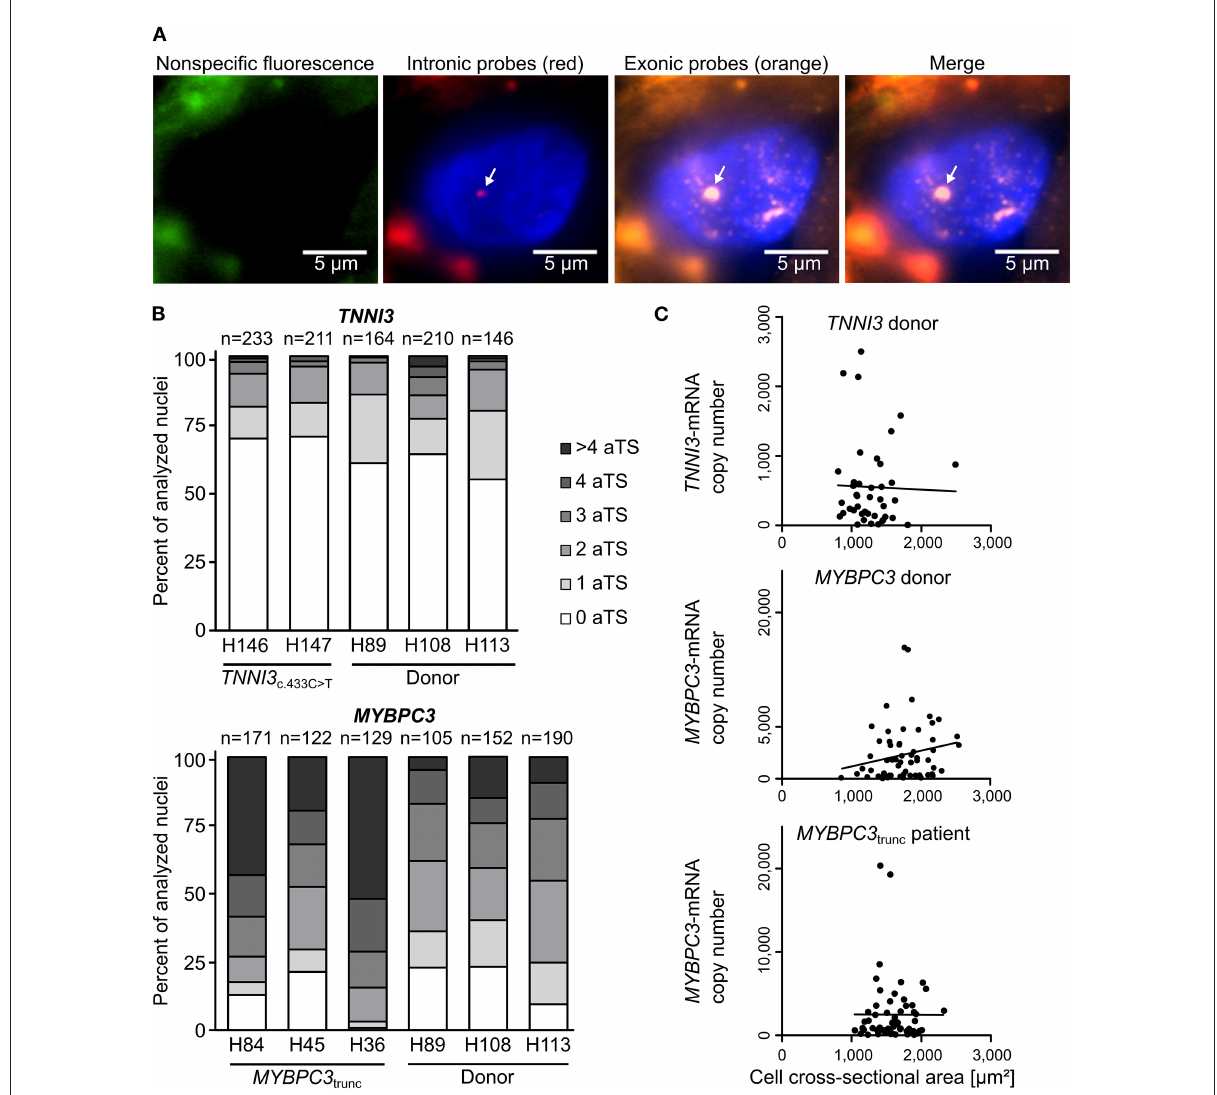
FIGURE1 Independent, stochastic transcription of TNNI3 - and MYBPC3 -alleles. (A) Exonic and intronic mRNA of either TNNI3 or MYBPC3 were hybridized with fluorescently labeled DNA probes to visualize active transcription in cardiomyocyte nuclei in cryosections from left ventricular heart tissue. Representative cardiomyocyte nucleus with one active transcription site (aTS) for MYBPC3 from the cMyBP-C trunc patient. Left panel (green) non-specific fluorescence, middle panels intronic RNA (red) and exonic RNA (orange) and right panel merge. Intronic and exonic signals are shown merged with DAPI (blue) to stain the nucleus. One layer of the z-stack is shown. White arrow indicates aTS with co-localization of Quasar 570 and Quasar 670 fluorescence. The other fluorescent spots in the nucleus are only stained by exonic probes and presumably represent spliced mRNA. (B) Distribution of the numbers of aTS per nucleus in cardiomyocytes for TNNI3 and MYBPC3 . Percentage of nuclei with 0, 1, 2, 3, 4, and > 4 aTS was plotted for different individuals. (C) TNNI3 - or MYBPC3 -mRNA copy number per cell plotted against the cell cross-sectional area. Linear correlation was tested using the Pearson correlation coefficient ( TNNI3 : r = − 0.0263, n = 41, p = 0.870; MYBPC3 donor: r = 0.1970, n = 63, p = 0.122 and MYBPC3 trunc patient: r = − 0.0030, n = 61, p = 0.982).